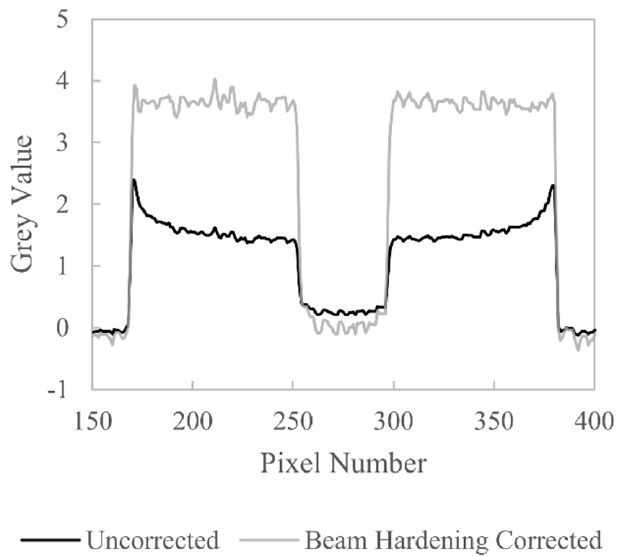
Figure 14. Comparison of line profiles drawn across the central row of the CT images in Figure 13. Grey value histograms evaluated from the uncorrected and beam hardening corrected data sets are shown in Figure 15. Two peaks are visible in these histograms: the leftmost peak represents background grey values, and the rightmost peak represents the aluminium grey values. The histogram for the uncorrected data shows a distortion in the aluminium material phase; this material phase should be approximately Gaussian in shape, when, in fact, it displays a positive skewness due to the raised grey values caused by beam hardening. However, after beam hardening correction, the aluminium material phase is restored to being approximately Gaussian. The histograms can be used to evaluate the grey value contrast improvement by calculating the grey value difference between the background peak and the material peak, M b and M m , respectively. The histograms can also be used to evaluate the noise in each data set; we evaluate the ± 34%